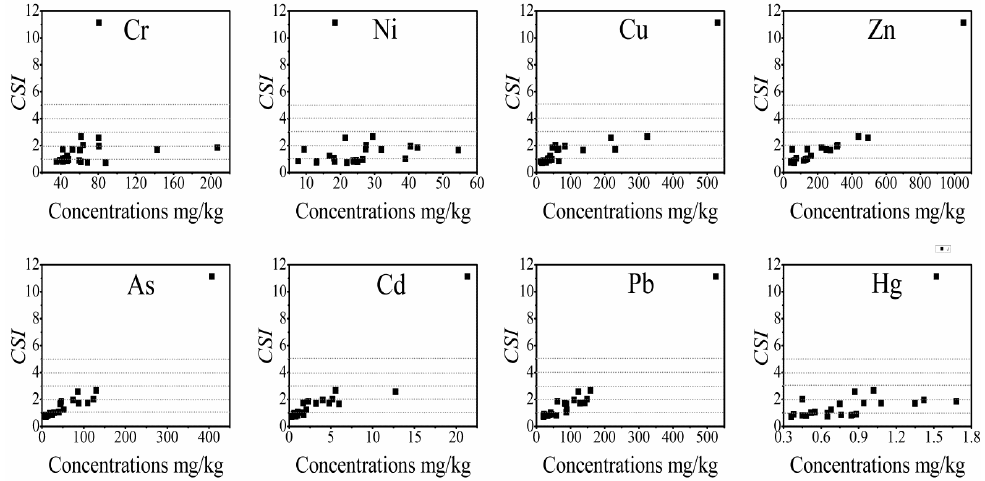
Figure 7. The CSI values of Cr, Ni, Cu, Zn, As, Cd, Pb, and Hg in sediments based on SQG values (ERL, ERM) and total heavy metal concentrations.